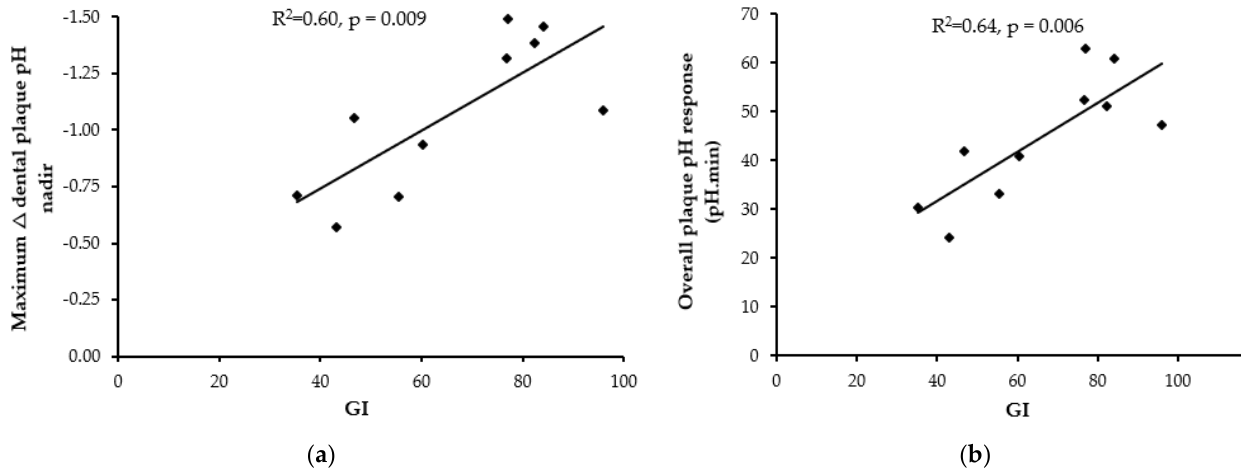
Figure 4. Linear correlation between GI of starchy foods tested in sub-study 2 ( n = 4 foods) and sub-study 3 ( n = 6 foods) and maximum nadir decrease in dental plaque pH at 22 min ( a ) or overall plaque pH response over 62 min ( b ). Each data point represents the average response in 12 healthy participants.